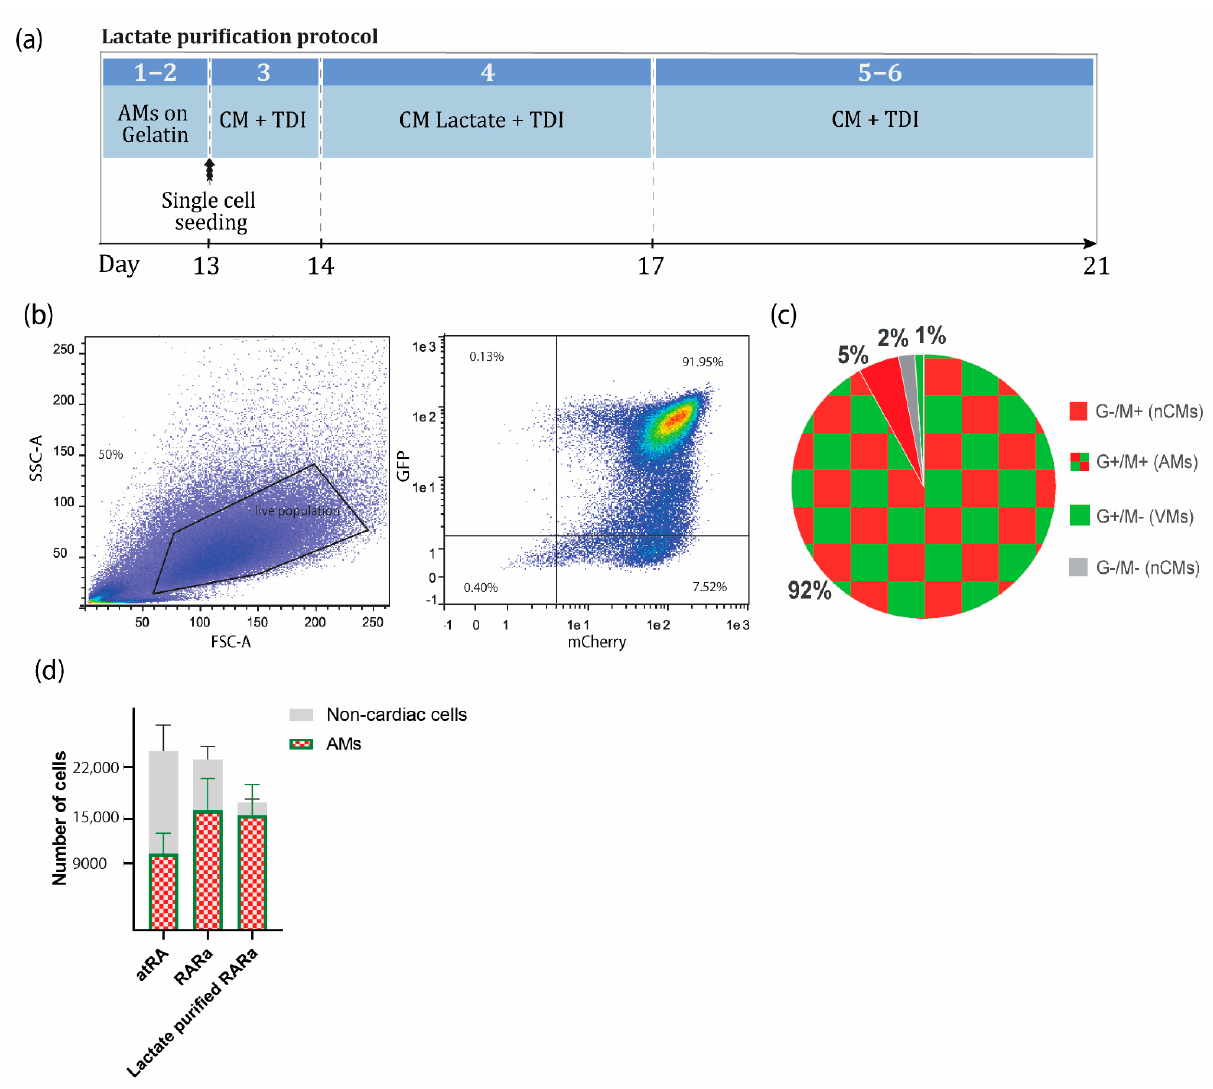
Figure 3. Metabolic selection of AMs. ( a ) Schematic representation of the lactate protocol from COUP-red RAR α -induced AMs. Steps correspond to the step-by-step section ‘D. Enrichment of AMs based on metabolic selection’ in Supplementary Materials. ( b ) Representative flow cytometry plots depicting the percentage of NKX2.5-GFP and COUP-TFII-mCherry-positive AMs at day 21 in RAR α -induced differentiation in spin EB format, followed by enrichment via lactate purification. ( c ) Pie chart representation of average flow cytometry percentages of NKX2.5-GFP (G + ) and COUP- TFII-mCherry-positive (M + ) AMs, G + /M − VMs, and G − /M − or G − /M − non-cardiac cells (n = 3). ( d ) Yield of atrial differentiation in atRA, RAR α , and lactate-purified RAR α . Data plotted as means ± S.E.M. (n = 3). AMs = atrial cardiomyocytes; VMs = ventricular cardiomyocytes; nCMs = non- cardiomyocytes; CM + TDI = cardiomyocyte medium plus TDI; CM Lactate + TDI = cardiomyocyte medium for lactate purification plus